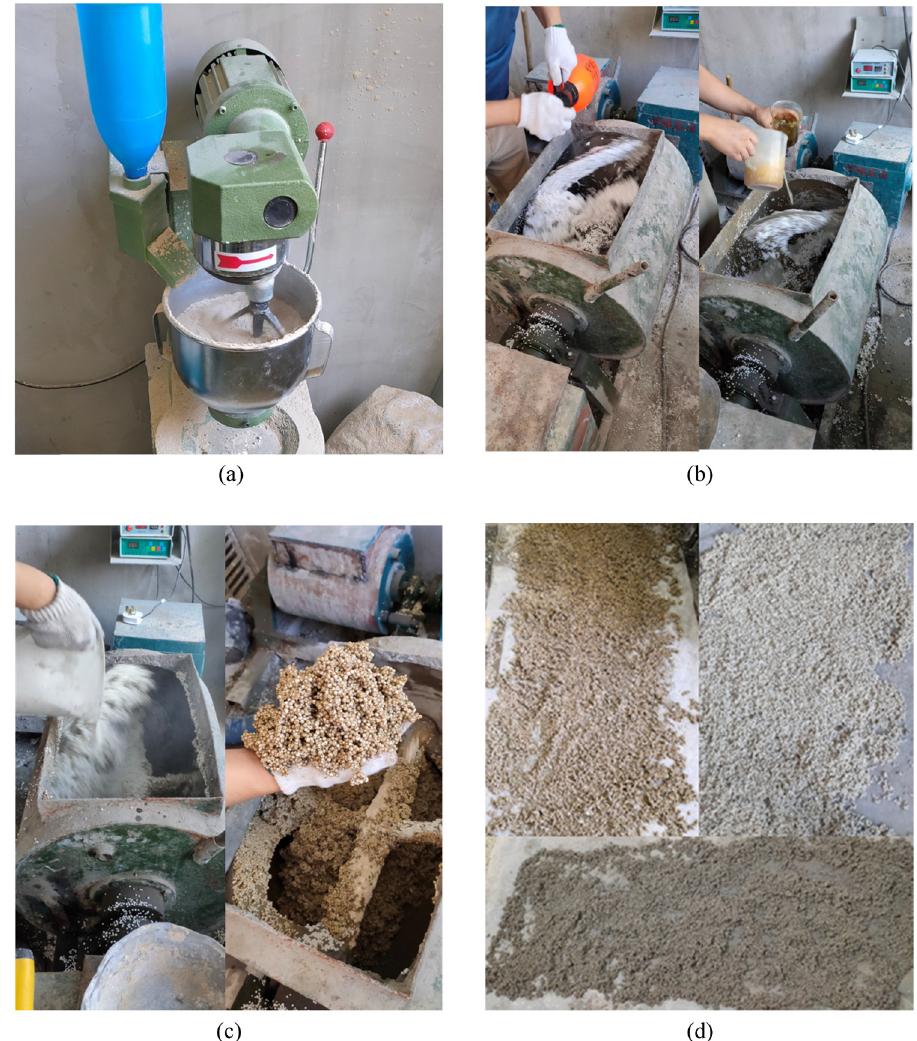
Figure 1: Manufacturing process of wrapped EPS beads: ( a ) powder mixing, ( b ) drop in solvent or WPU, ( c ) EPS beads wrapping, and ( d ) aging of wrapped EPS